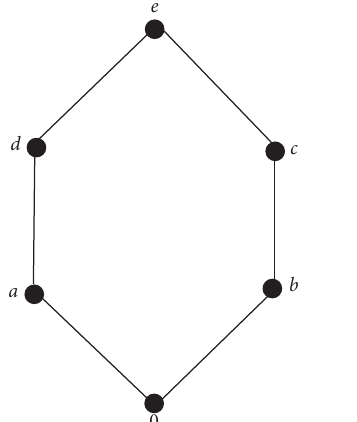
Figure 2: An L -fuzzy ideal μ of a poset Q for which μ : x need not to be L -fuzzy ideal for x ∈ Q